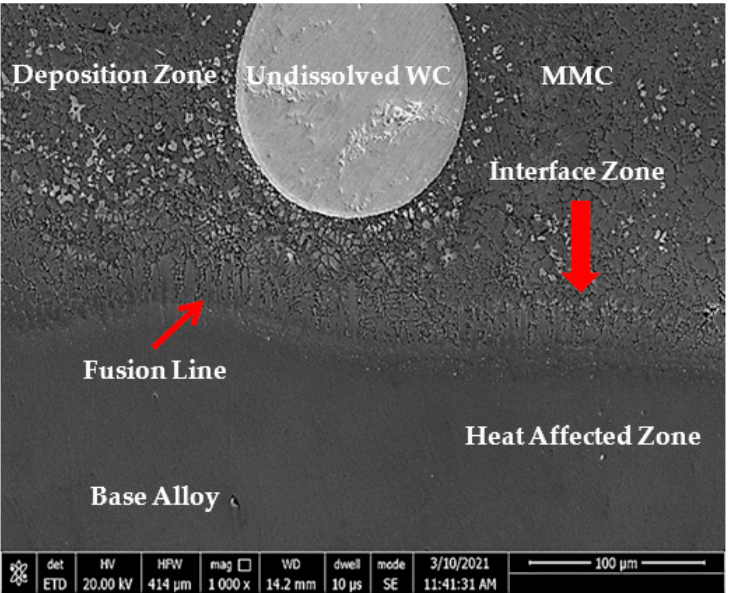
Figure 9. FESEM micrograph of a cross-section of S2 across the whole deposited layer showing three different zones of deposition, interface and HAZ.